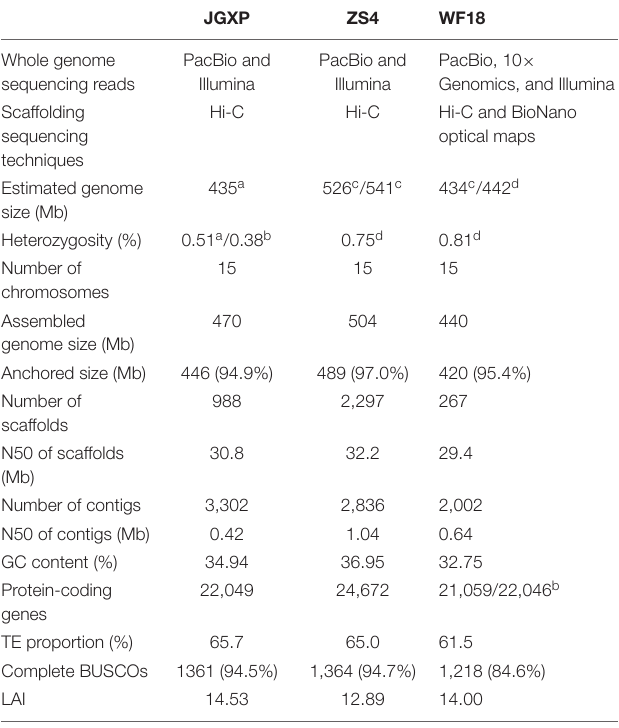
TABLE 1 | Statistics of the three yellowhorn assemblies of “JGXP,” “ZS4,” and “WF18”. N50, shortest sequence length at 50% of the genome. JGXP